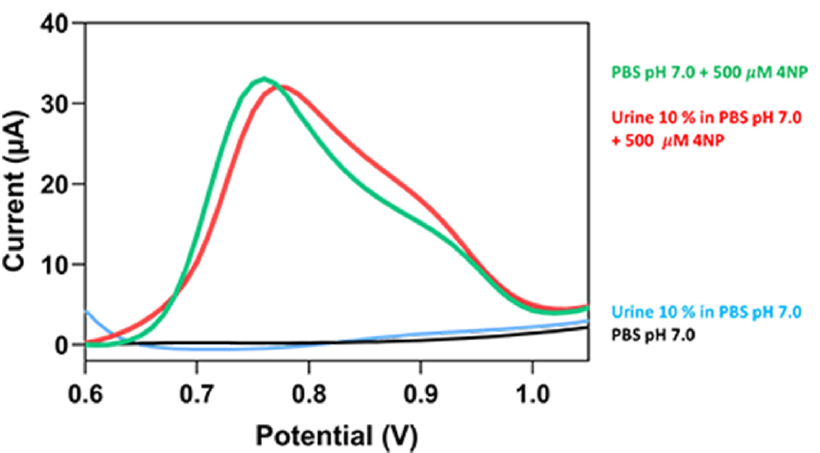
Figure 3. Differential pulse voltammograms (DPVs) from a 3-mm-diameter BDD disk electrode in 0.1 M PBS pH 7.0 containing 0 (black trace) and 500 µ M (green trace) 4NP. Light blue and red traces are DPVs obtained through the operation of a BDD sensor in urine diluted 10-fold in 0.1 M PBS pH 7.0 without and with the addition of 500 µ M 4NP, respectively. Parameters for DPV acquisition were as listed in Figure 2.